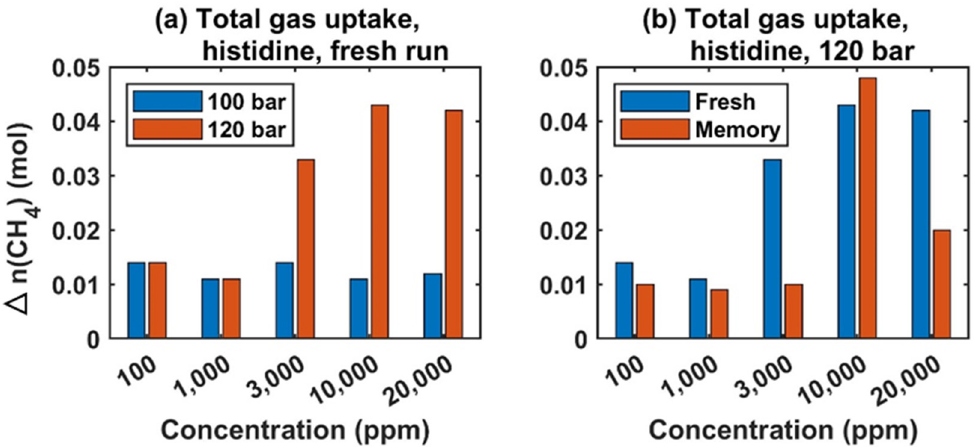
Figure 9. Total CH 4 uptake during the isothermal experiment at 1 °C for histidine at different concentrations. ( a ) Total gas uptake profiles for different concentrations under 100 bar and 120 bar. ( b ) Total gas uptake variation for different concentrations under 120 bar for fresh and memory run.